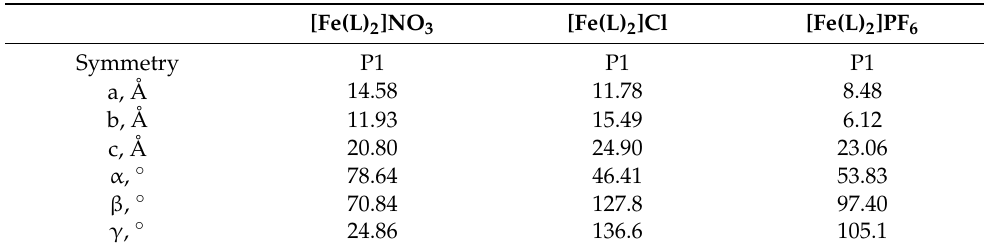
Table 1. Crystallographic data for compounds 1 – 3